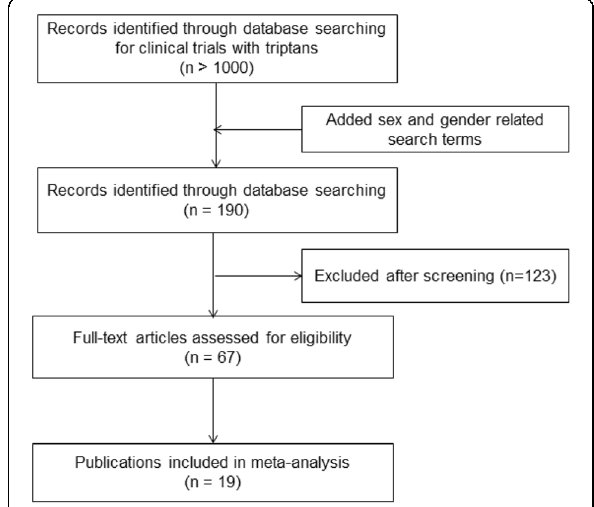
Fig. 1 (abstract P85). Flowchart of publication selection process.